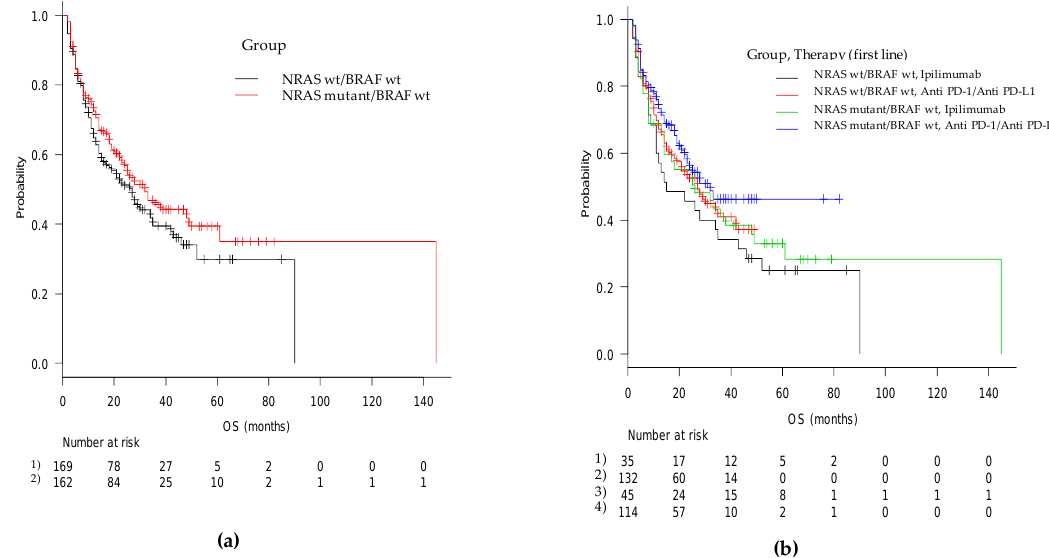
Figure 2. Kaplan-Meier curves of overall survival from first-line immune-based therapy in ( a ) the mut/wt and wt/wt cohorts and in ( b ) the two groups according to checkpoint inhibitor utilized (anti-PD-1 and anti-CTLA4). The 3 patients in the mut/wt group who were treated with ipilimumab plus nivolumab In the univariate analysis, a longer OS was associated with normal LDH levels ( p < did not progress after 30, 34 and 39 months. In contrast, in the wt/wt group, the patient 0.001), <3 metastatic sites ( p < 0.01), lower white blood cell count ( p = 0.03), lower platelet obtaining SD died after 8 months, and the other responder patient was progression free count ( p = 0.01), lower N/L ratio ( p < 0.01), and site of the onset melanoma ( p = 0.03) (Table 8). after 41 months. In the univariate analysis, a longer PFS was associated with the use of anti-PD-1 as Table 8. Univariate and multivariate analysis of overall survival. the first-line therapy ( p < 0.0001), normal LDH levels ( p < 0.01), and <3 metastatic